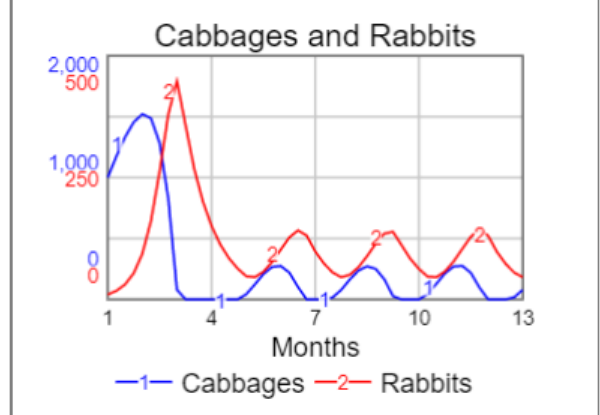
Fig. 27. Stella model output for